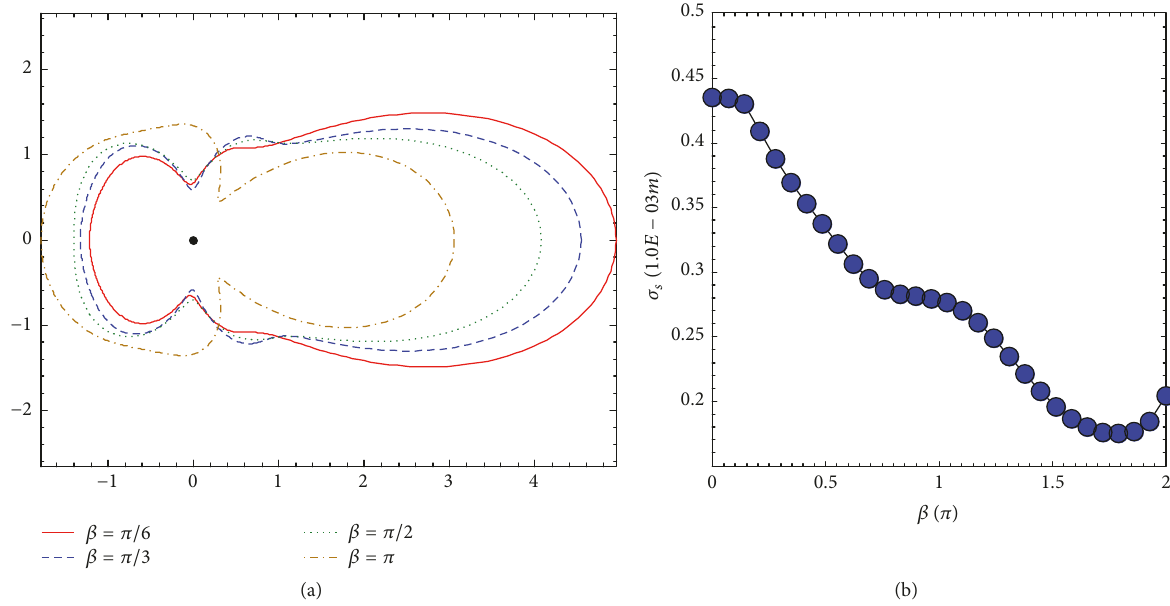
Figure 6: Influence of 𝛽 on (a) the far-field scattering magnitude and (b) 𝜎 𝑠 at 𝑘 𝑚 𝑎 = 3.0 and 𝛼 = 0.0 .